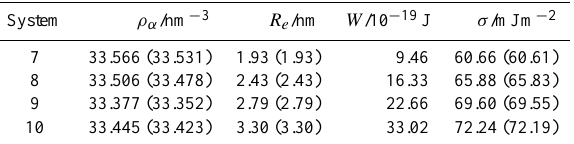
smaller droplets. Figure 3 shows the number densities for glycine molecules and water molecules in the droplets. The peaks in the 0 < r < 0.5 region do not mean much due to the lack of statistics. It can be seen that in all droplets the density of glycine vanishes at the surface, indicating that the zwitte- rionic glycine molecules are very hydrophilic and prefer the bulk phase of the droplet. The P N (r) profiles for systems 7–10 are also calculated, as shown in Fig. 4. Comparing to Fig. 2, the P N (r) curves for systems 7–10 also have similar peaks near the surface. This is in accordance with the fact that the glycine molecules stay inside the droplet and have minor effect on the surface of the droplet. Consequently, the P N (r) curve in bulk phase of the droplet is significantly affected by the presence of glycine molecules. The glycine-induced 1P N (r) is also shown in Fig. 4. Here 1P N (r) is the difference between the P N (r) values of the glycine-containing droplet and the pure water droplet. It can be seen that the presence of glycine molecules has an undulate effect on the P N (r) curve. Although glycine molecules mainly reside in the bulk of the droplet, a small influence can be found in the surface region of the P N (r) curve. Inside the droplet where glycine molecules assemble, the value of 1P N (r) goes negative and therefore tends to reduce the surface tension. As the droplet size increases, the 1P N (r) curve becomes closer to zero inside the droplet